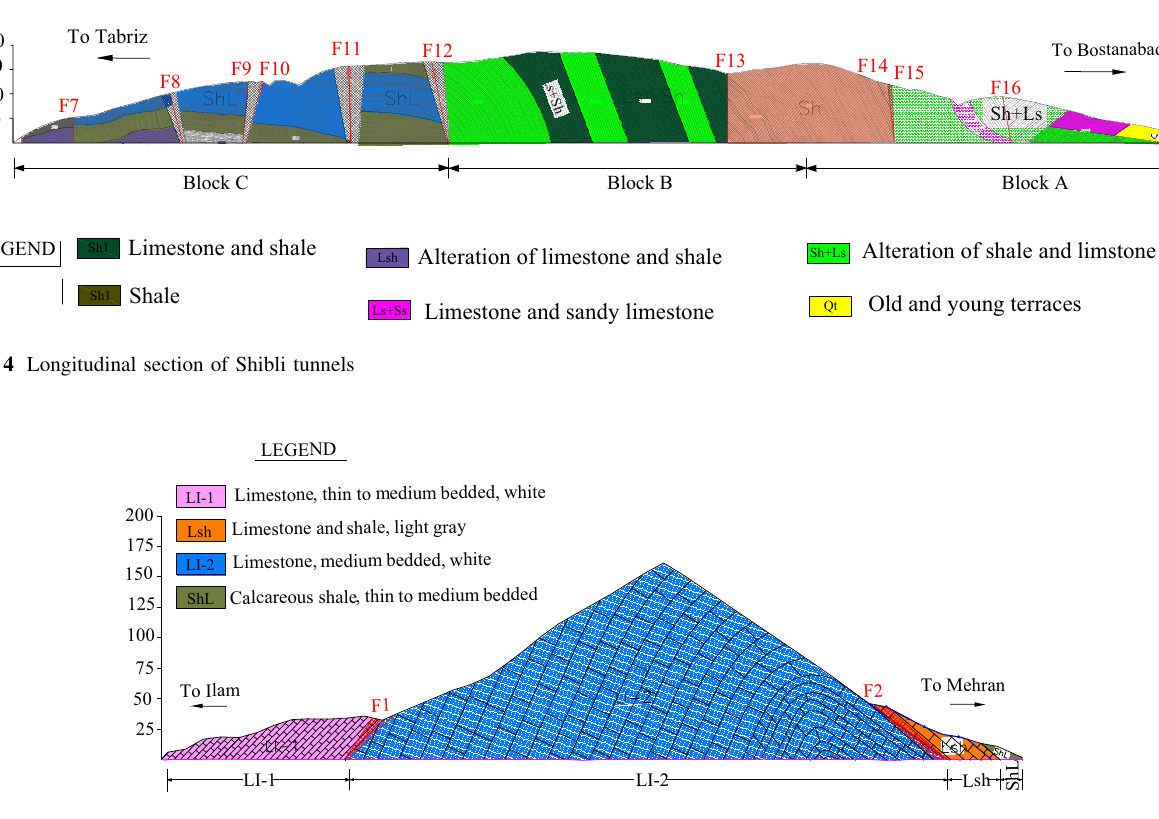
Fig. 5 Longitudinal section of Ilam-Mehran